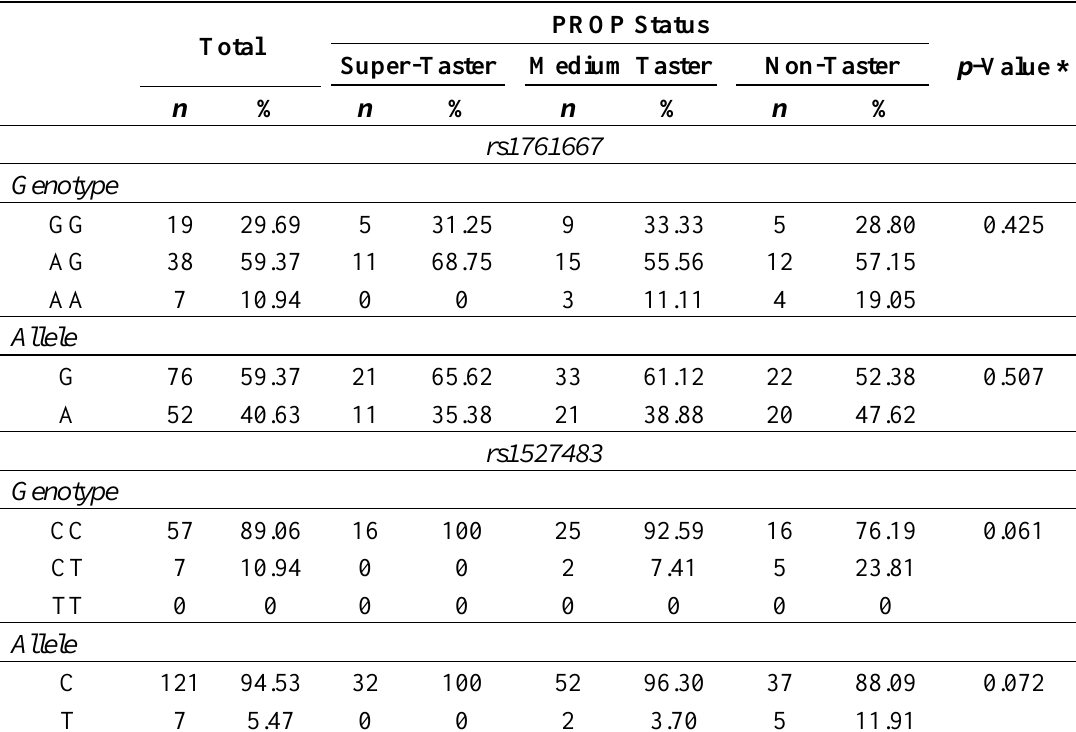
Table 1. Genotype distributions and allele frequencies of rs1761667 and rs1527483 polymorphisms of CD36 according to PROP taster status.